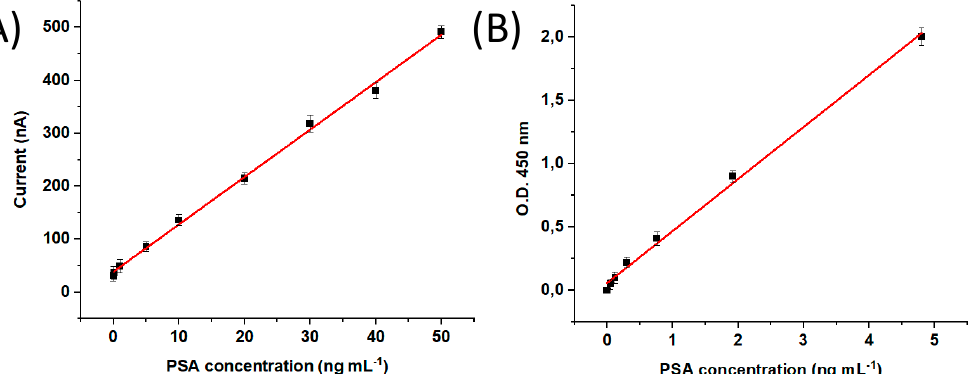
Figure 4. ( A ) Calibration curve of microfluidic immunosensor, and ( B ) calibration curve of commercial ELISA kit for PSA cancer biomarker.